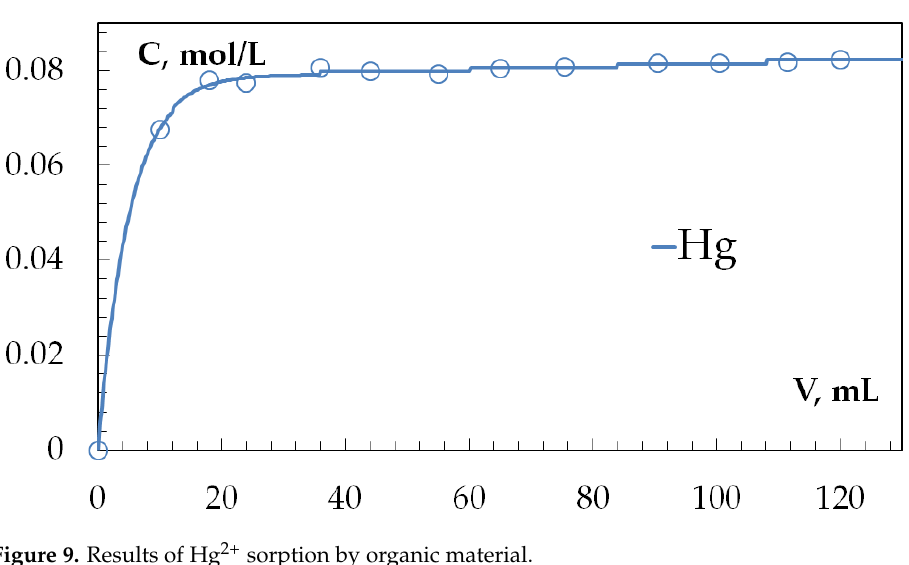
Figure 8. Results of Fe 3+ sorption by organic material.